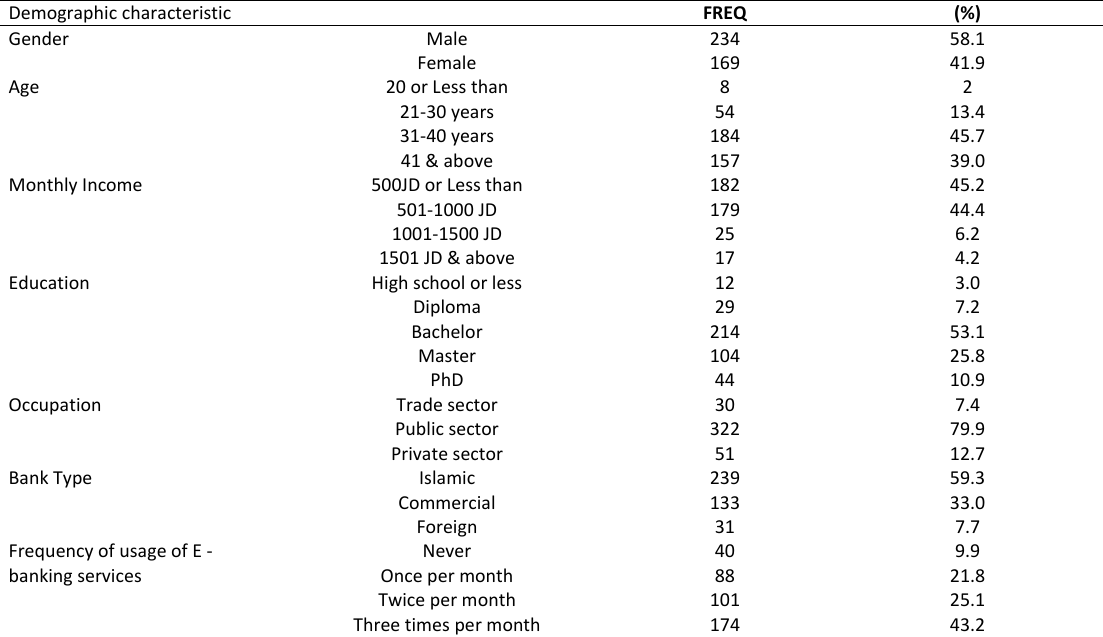
Table1: Demographic characteristics (N=403)